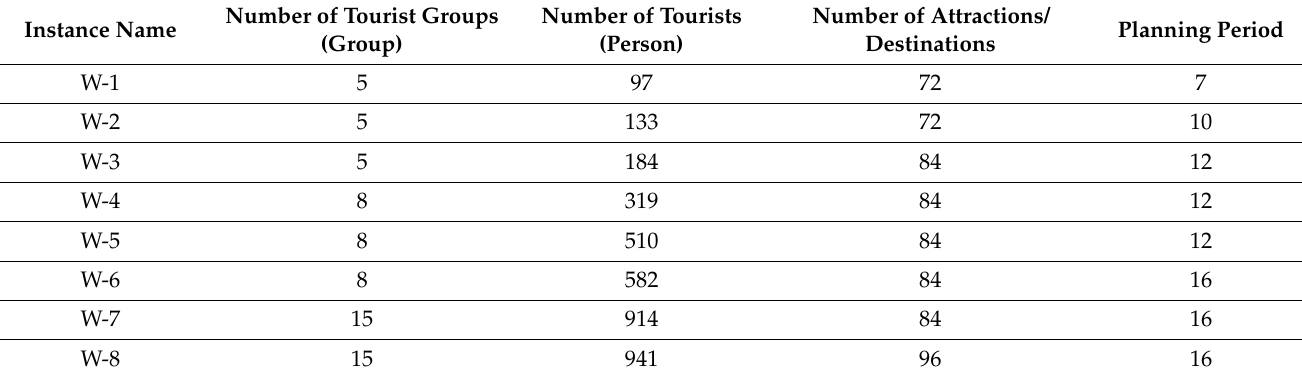
Table 5. Information about the random data set and the case